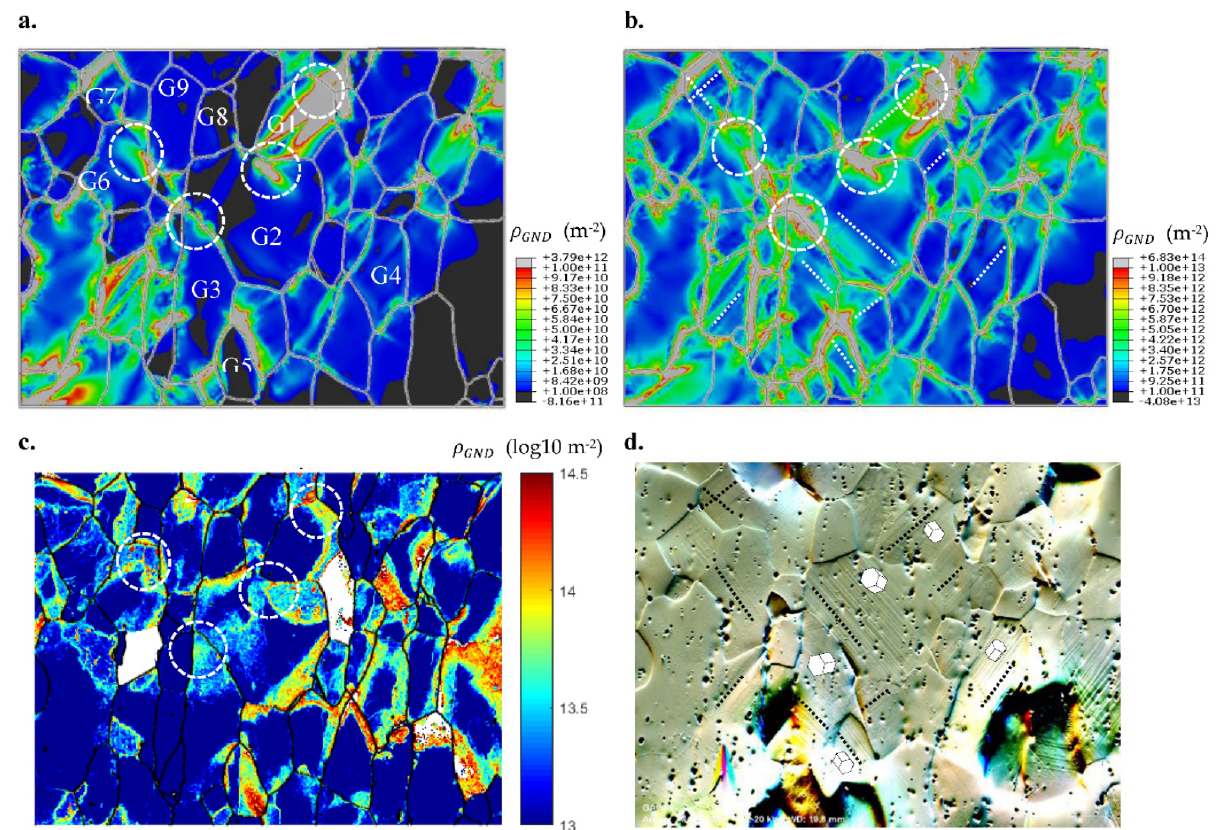
Figure 5. The distribution of total GND density from ( a ) CPFE model using Method I, ( b ) CPFE model using Method II. and ( c ) HR-EBSD. ( d ) SEM-ARGUS image of the deformed sample. In ( d ) slip bands are shown with the black dashed lines and crystal orientations are shown using HCP crystals.